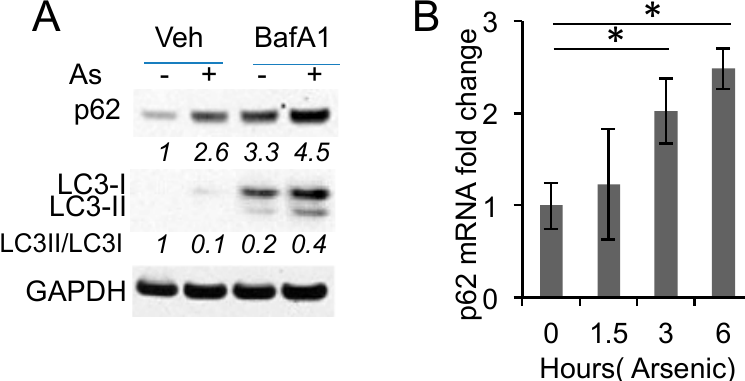
Figure 2. Arsenic induces p62 expression independent of autophagy: ( A ) (mmunoblot analysis of p62, LC3-I/II, and GAPDH in HaCaT cells treated with or without arsenic (8 μ M) and bafilomycin A1 (BafA1, 10 nM) for 6 h. Cells were pretreated with BafA1 for 30 min prior to arsenic treatment; ( B ) Real-time PCR analysis of the p62 mRNA levels in HaCaT cells treated with or without arsenic (8 μ M) over a time course. * p < 0.05, Student’s t -test, statistically significant between comparison groups.